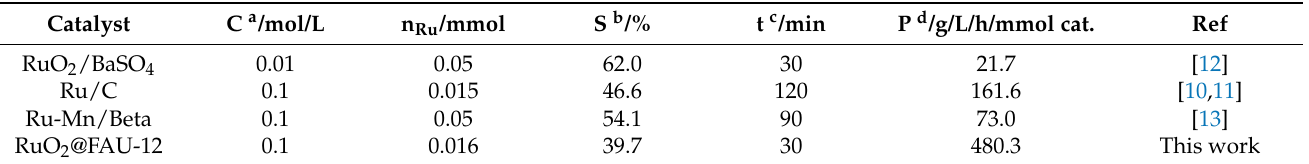
Table 2. Performance of varied supported ruthenium oxide in decarboxylation of L-lysine to